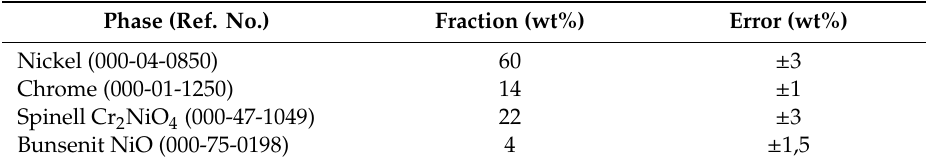
Table 3. Rietveld analysis taken from XRD spectrum in Figure 8.